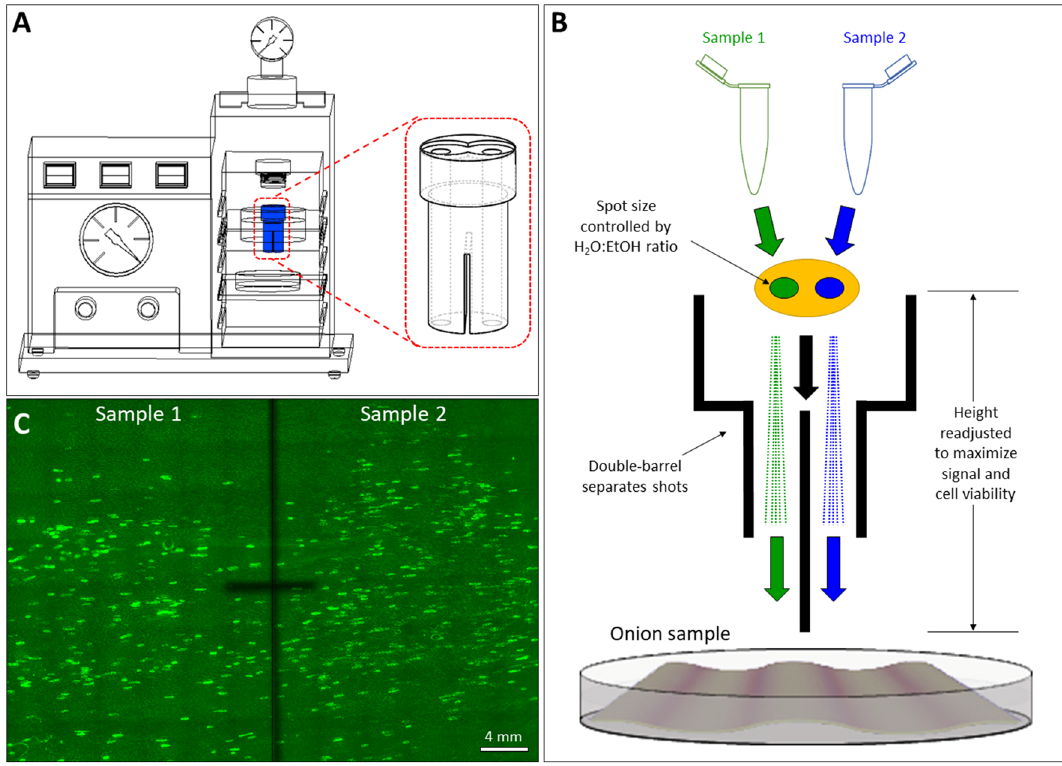
Figure 1. Overview of biolistic bombardment of onion epidermis tissue using the double-barrel device. ( A ) A detailed view of the double-barrel in the PDS-1000 gene gun; ( B ) schematic diagram demonstrating the modifications to the biolistic procedure to accommodate the double-barrel device; ( C ) a typical tile-scan fluorescent image of onion tissue bombarded with plasmid DNA with a gene expressing GFP. The dark cross in the middle is marked to separate the sample areas impacted by the two sides of the double-barrel